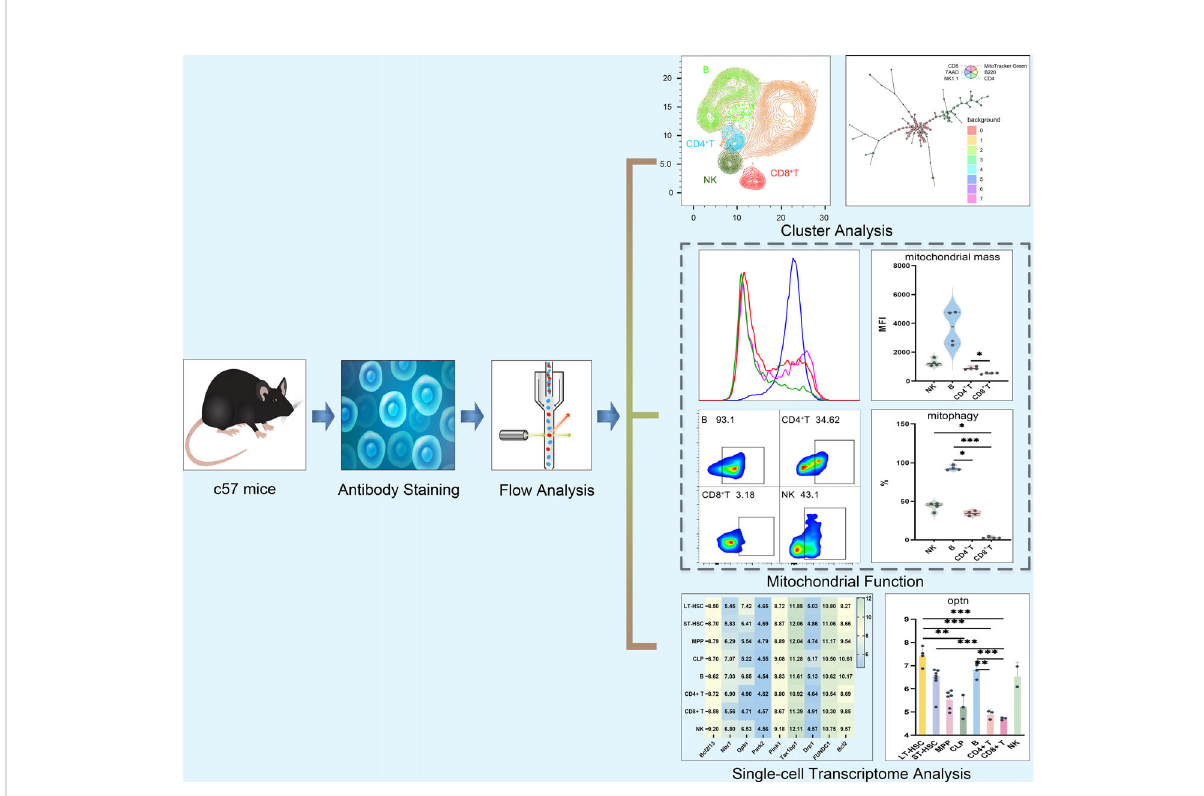
FIGURE 1 Schematic diagram of mitochondrial functions in different subsets of